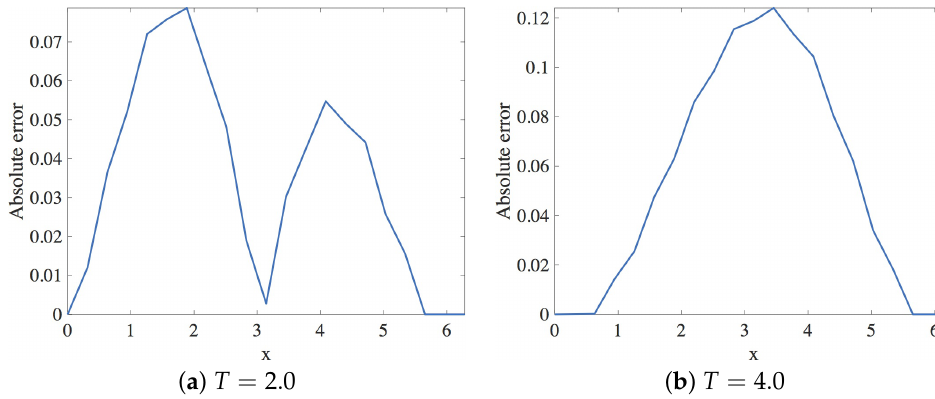
Figure 14. Plot of the absolute error vs. x using Scheme 3 for Numerical Experiment 1. The spatial and temporal step sizes are h = π /10 and k = 0.001,